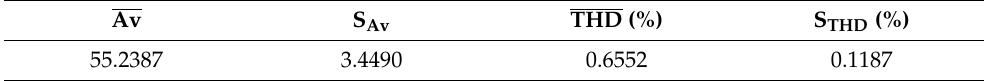
Table 6. Average and standard deviation values obtained from the Monte Carlo analysis with the